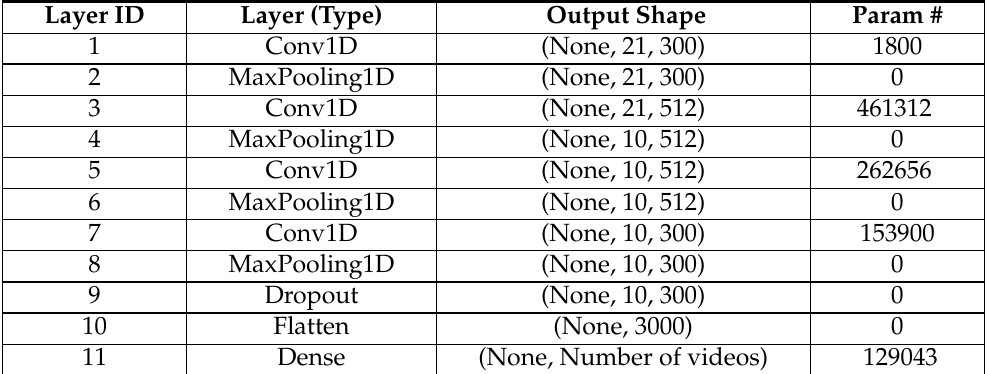
Table 2. Summary of the F-PAT